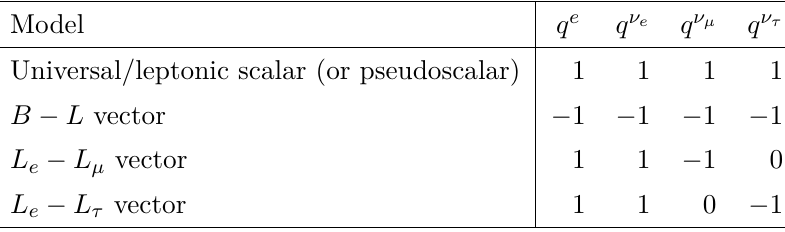
Table 1 . Charges for the vector, scalar, and pseudoscalar mediators considered in this